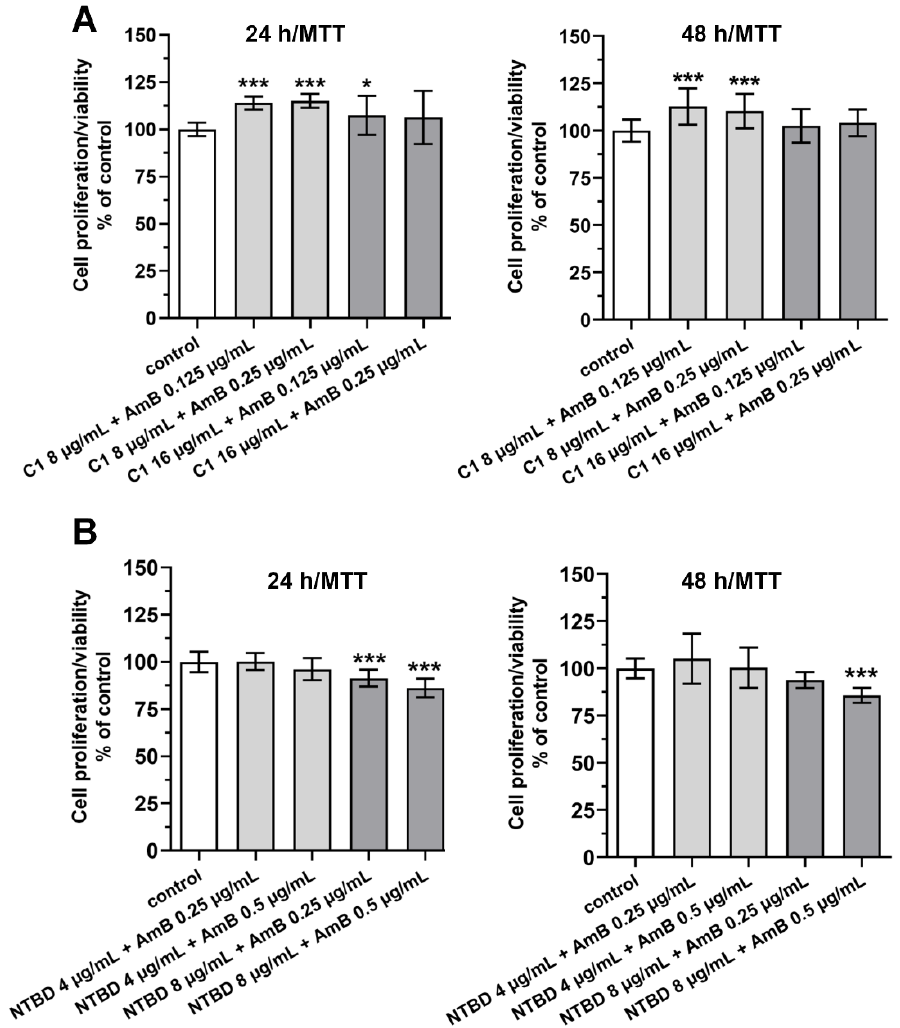
Figure 2. The impact of the combination of AmB with thiadiazols C1 ( A ) or NTBD ( B ) on the viability of RPTEC cells. The cells were incubated with either AmB, C1, and NTBD alone or with the mixture AmB + C1 ( A ) and AmB + NTBD for 24/48 h, and the cell viability/mitochondrial dehydrogenase activity was assessed by MTT assay. Results were expressed as % viability of cells as compared to vehicle (DMSO) control (mean ± SD). Values are significantly different from control if p < 0.05 *, p < 0.001 ***, using the one-way ANOVA test. Results are shown as a representative of three independent